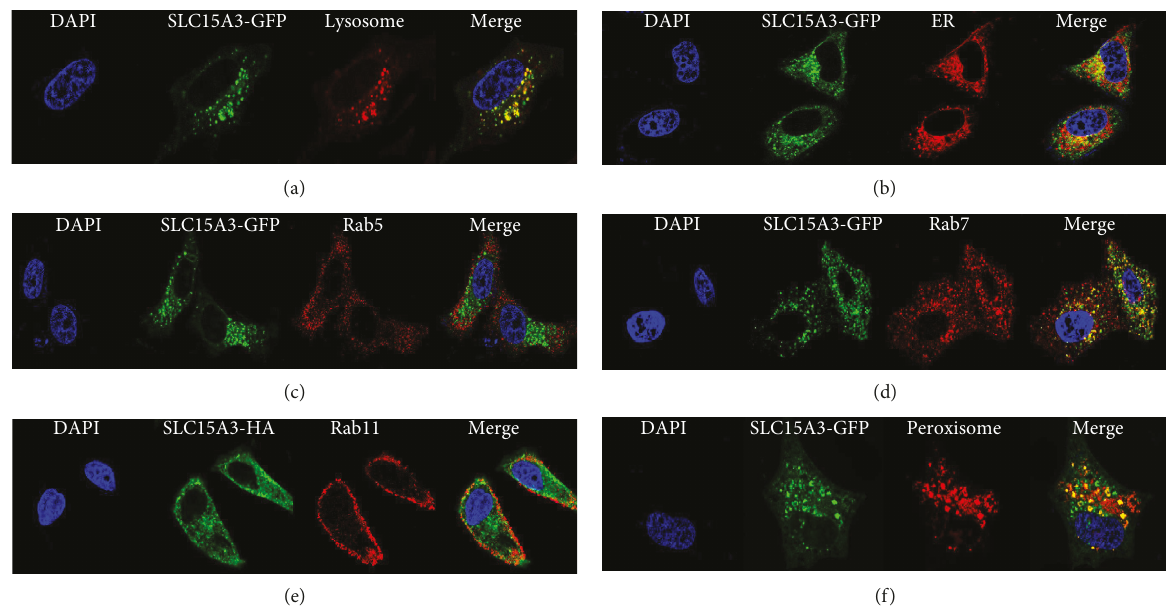
Figure 2: SLC15A3 is located at lysosomes, late endosome, and peroxisome. Confocal microscopy observation of HeLa cells transfected with SLC15A3-GFP (green) and lysosome tracker (a), ER tracker (b), endogenous Rab5 (c), endogenous Rab7 (d), endogenous Rab11 (e), and RFP-PXMP2 (peroxisome tracker)